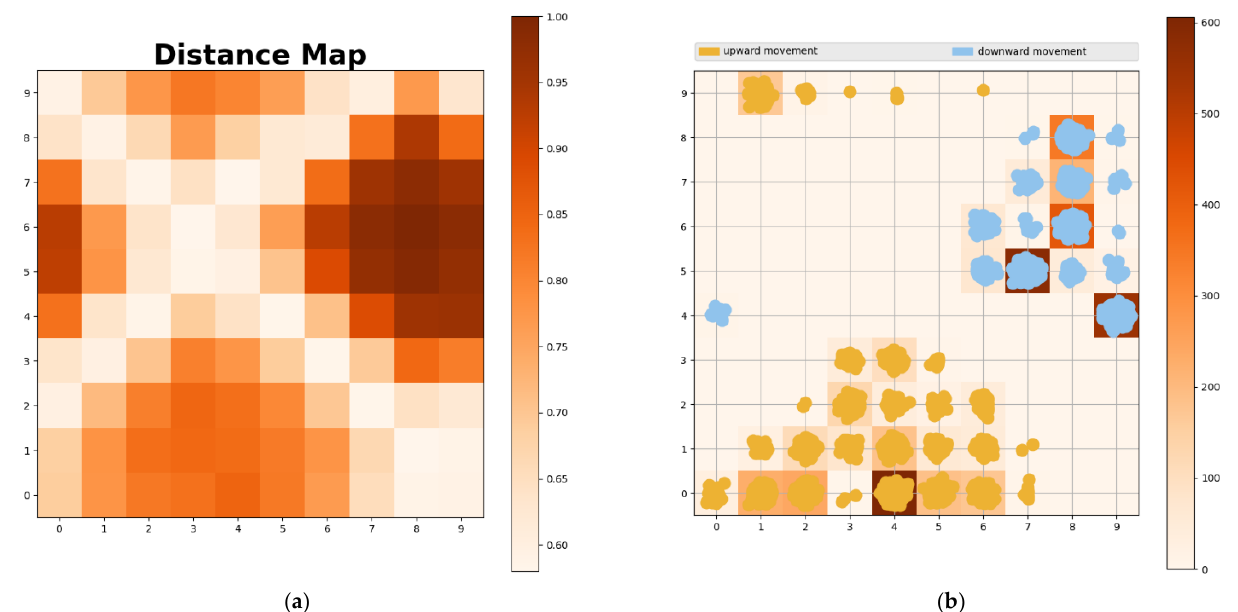
Figure 8. ( a ) Distance map for the whole dataset; ( b ) SOM representation of barrier machine opening (yellow) and closing (blue) current waveforms.